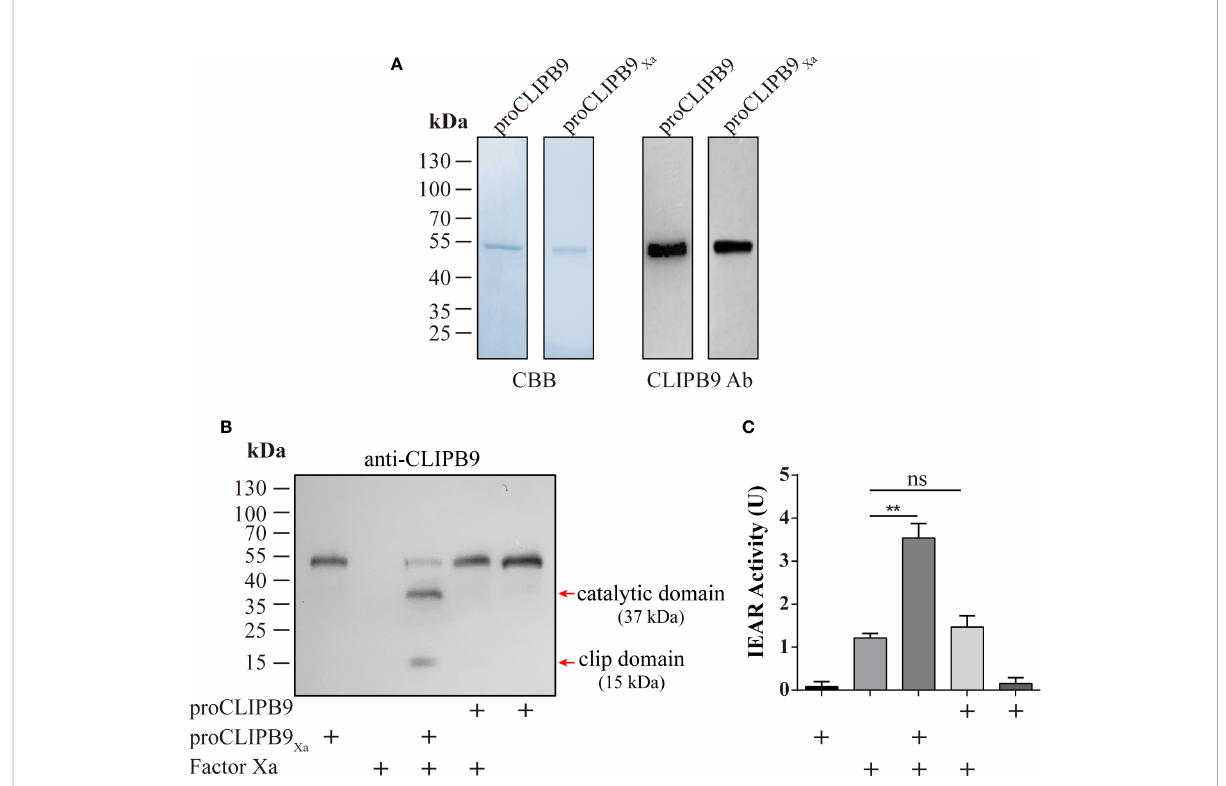
FIGURE 2 Puri fi cation and activation of recombinant proCLIPB9 and proCLIPB9 Xa . (A) Puri fi ed recombinant proCLIPB9 and proCLIPB9 Xa were analyzed by SDS-PAGE and immunoblotting. Left, CBB staining; Right, immunoblotting assays using anti-CLIPB9 antibody (CLIPB9 Ab). (B) The cleavage of puri fi ed proCLIPB9 Xa by Factor Xa was detected by immunoblotting. After incubation of Factor Xa with proCLIPB9 (100 ng) or proCLIPB9 Xa (100 ng), immunoblotting was performed using anti-CLIPB9 antibody. (C) Amidase activity assay of CLIPB9 Xa . The catalytic activity of CLIPB9 Xa cleaved by Factor Xa was detected using IEAR p Na as a substrate. The bars represent the mean ± SEM (n = 3). **P < 0.01; ns, P >